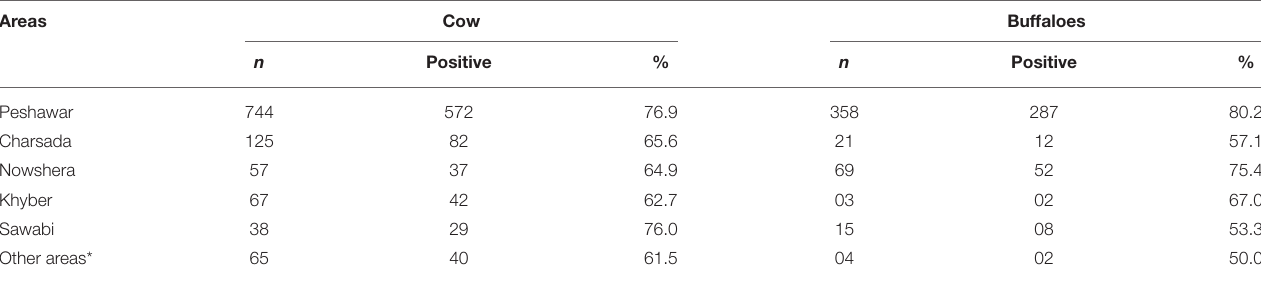
TABLE 4 | Area-wise prevalence of bovine mastitis in cattle and buffaloes. Areas Cow Buffaloes